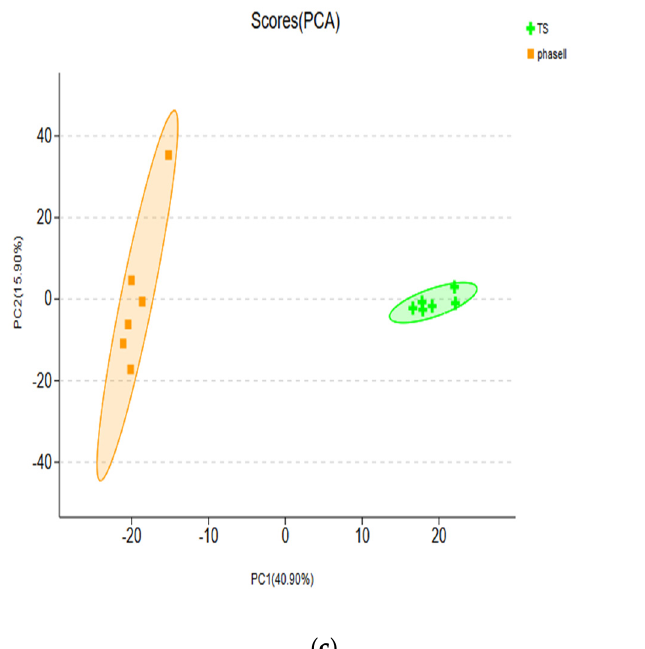
Figure 4. Principal component analysis of samples. ( a ) PCA analysis of all groups ( b ) PCA analysis of the N1Fand Phase I ( c ) PCA analysis of the TS andPhase I.